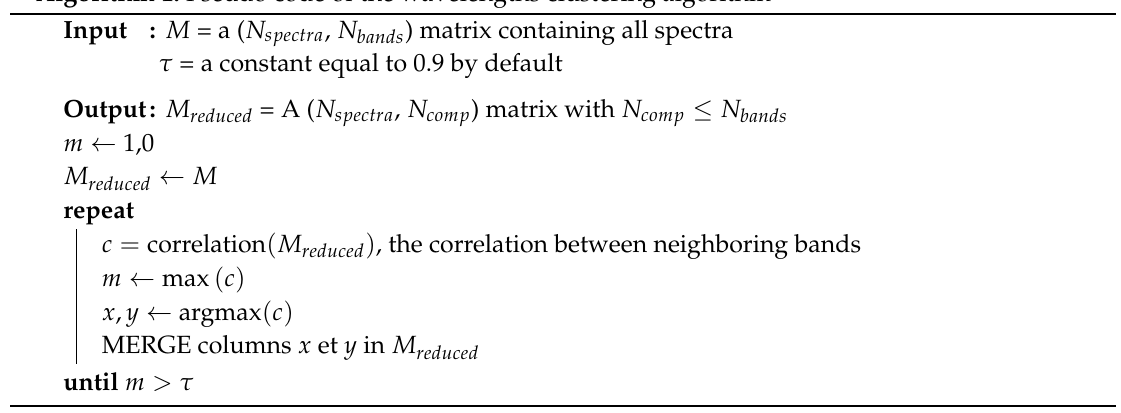
Algorithm 1: Pseudo code of the wavelengths clustering